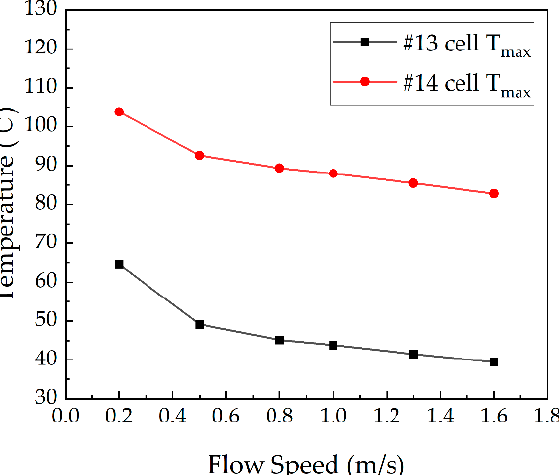
Figure 11. The maximum temperature of the battery module at different flow speeds. (For #14 near the middle.)